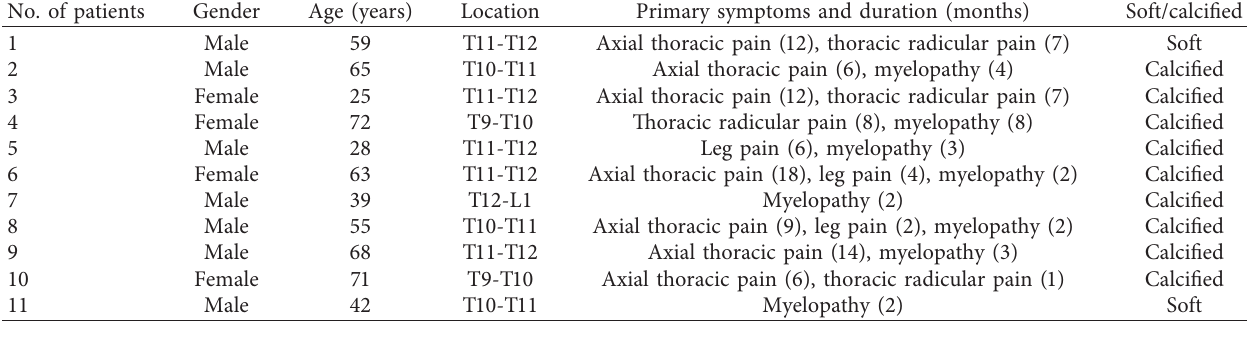
Table 1: Summary of the clinical and imaging characteristics of the 8 cases who underwent full-endoscopic transforaminal ventral decompression